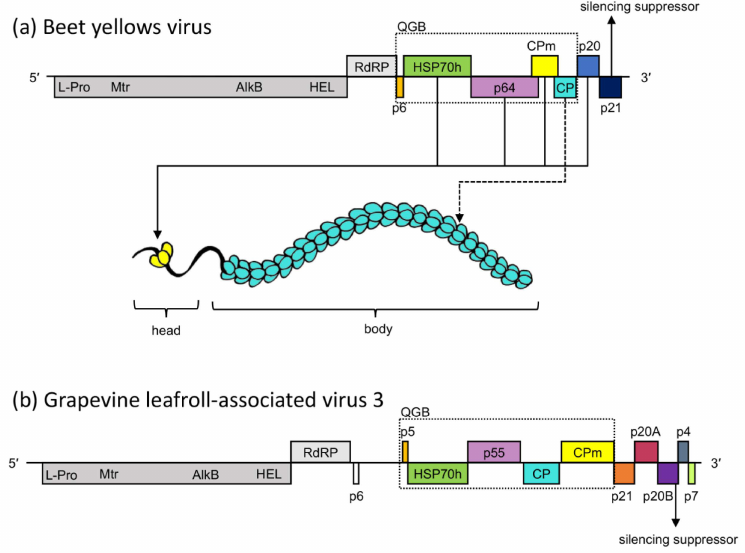
Figure 1. ( a ) Genome organisation of beet yellows virus (BYV) from the genus Closterovirus , family Closteroviridae , with an illustration of the bipartite virion of members of this family. Involvement of the structural proteins in the two parts of the virion is indicated by arrows. ( b ) Genome organisation of grapevine leafroll-associated virus 3 (GLRaV-3). Genes encoding homologous proteins are filled with the same colour. L-Pro: leader papain-like protease; Mtr: methyltransferase; AlkB: AlkB